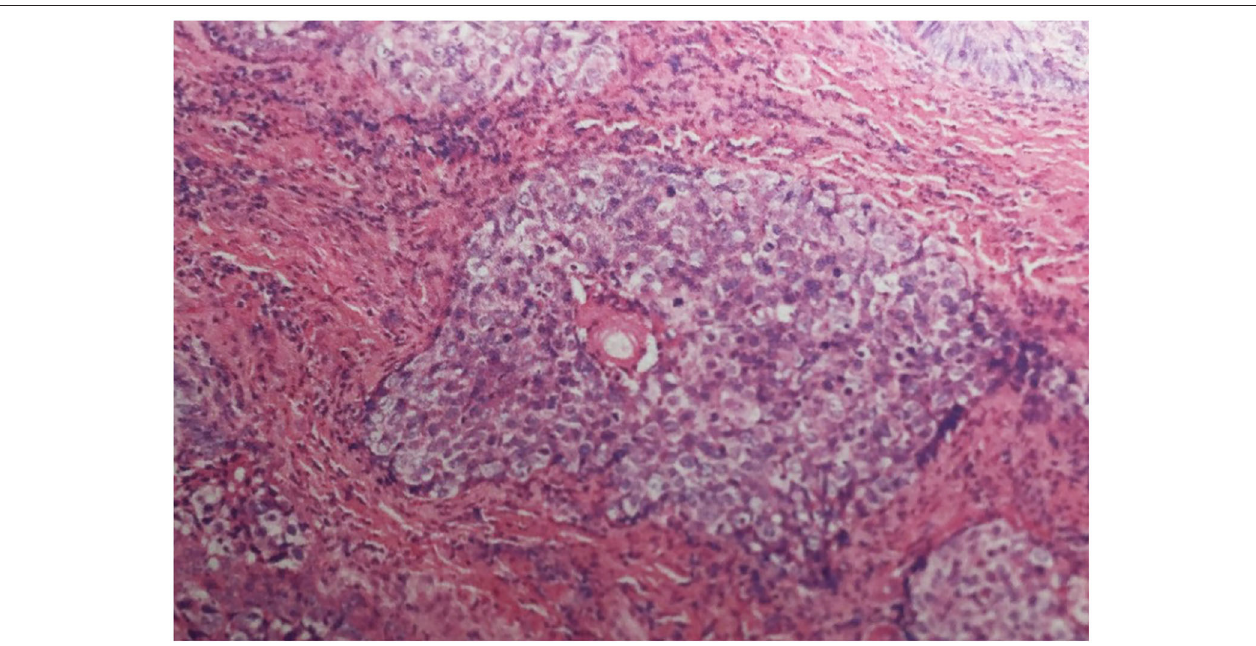
FIGURE 2 | Histological section demonstrating infiltrative lobules of clear cells composed of large, polygonal, clear cells with eccentric nuclei (Haematoxylin-eosin stain; magnification ×